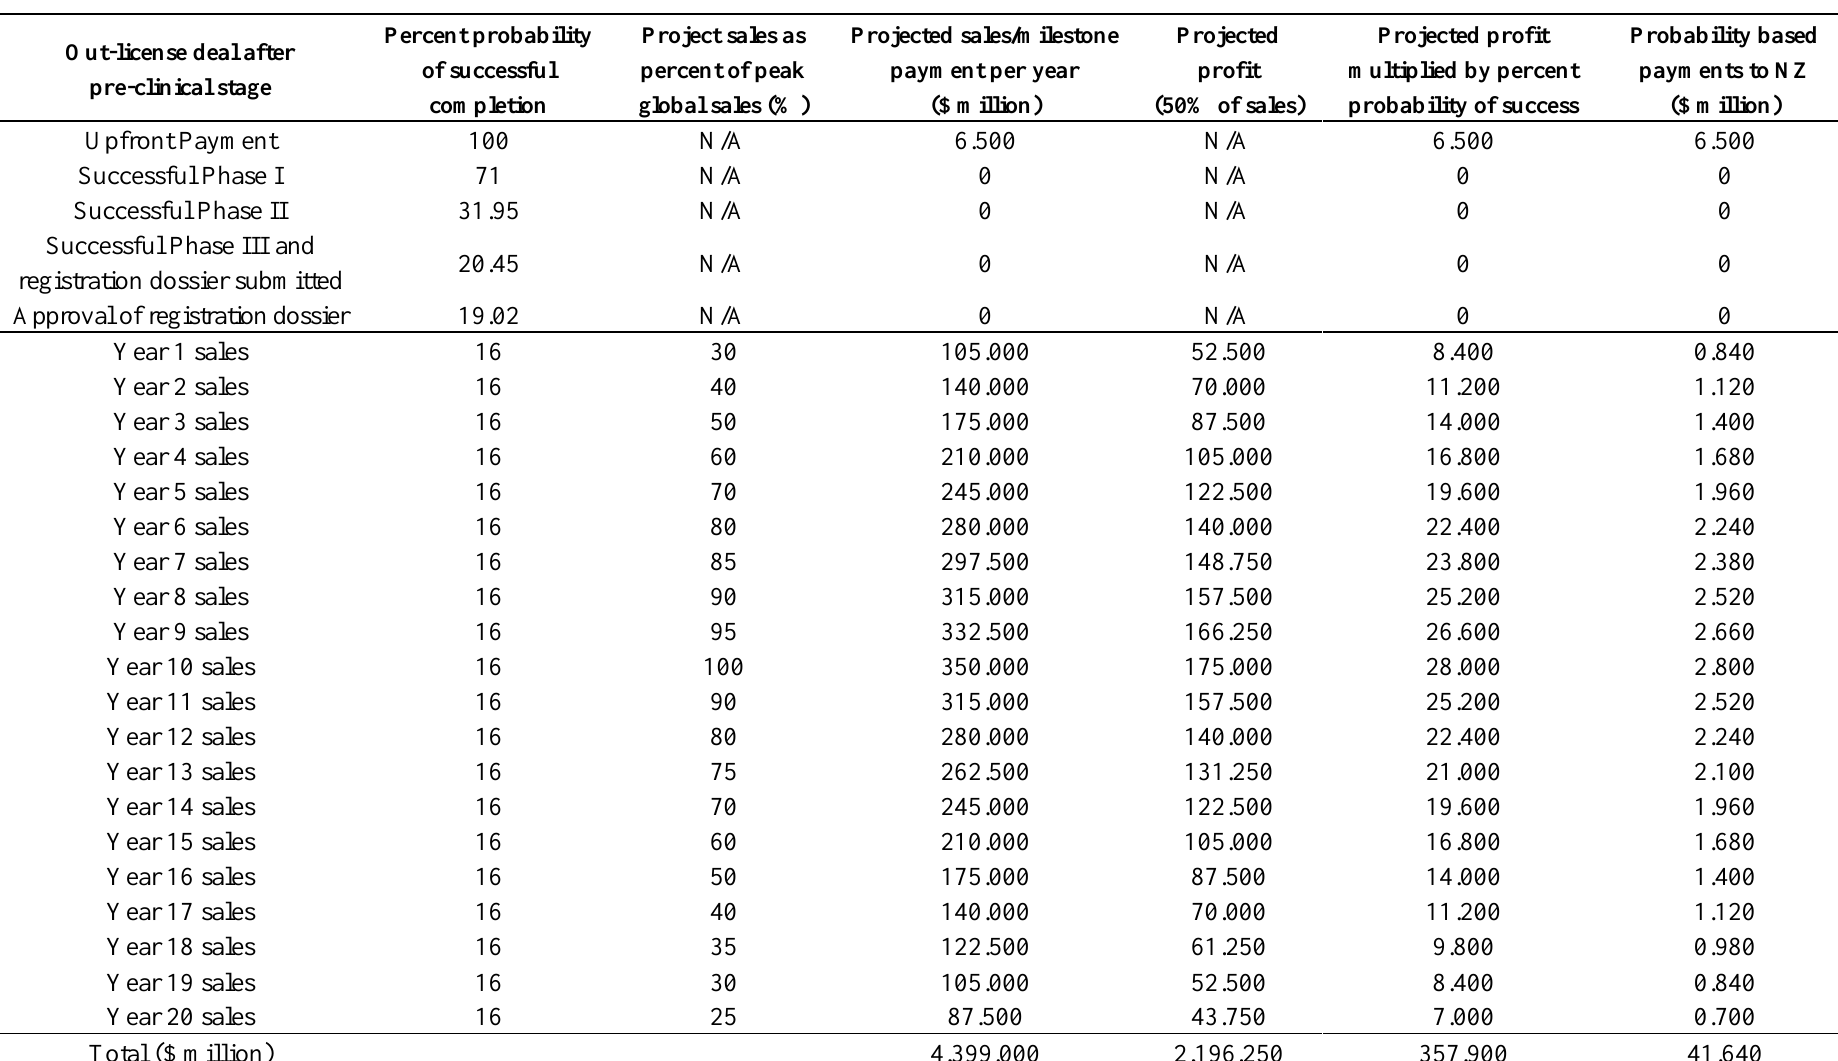
Table 2. Revenue from the out-license of a NZ-discovered